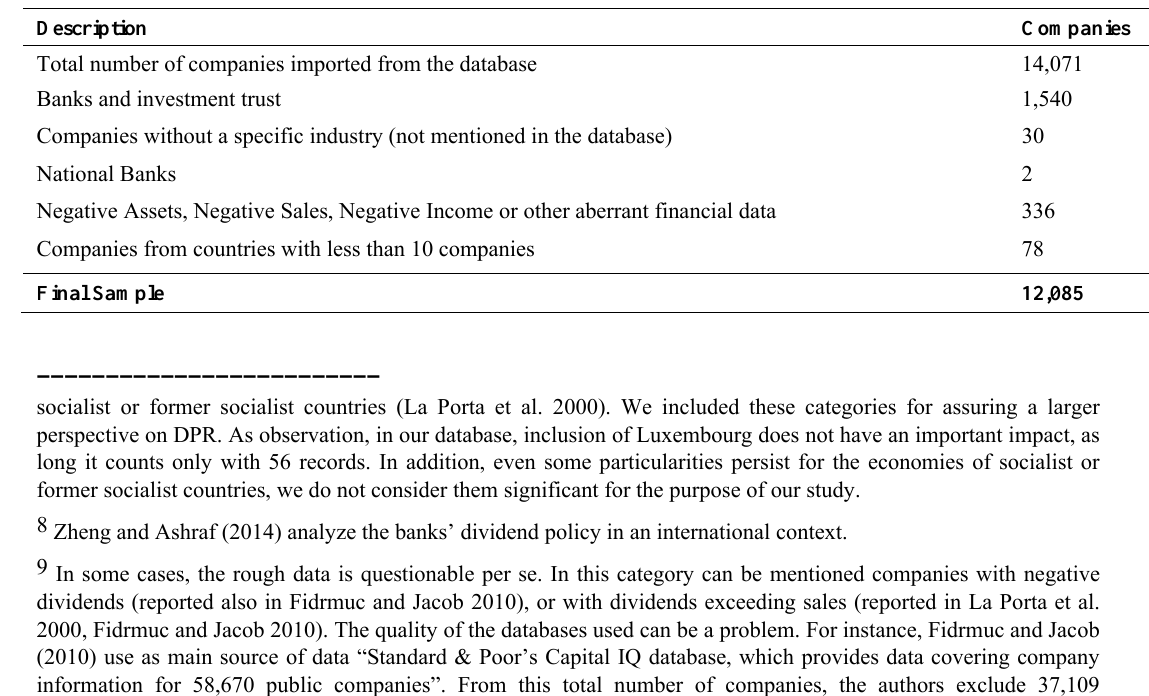
Table 2 : Final sample